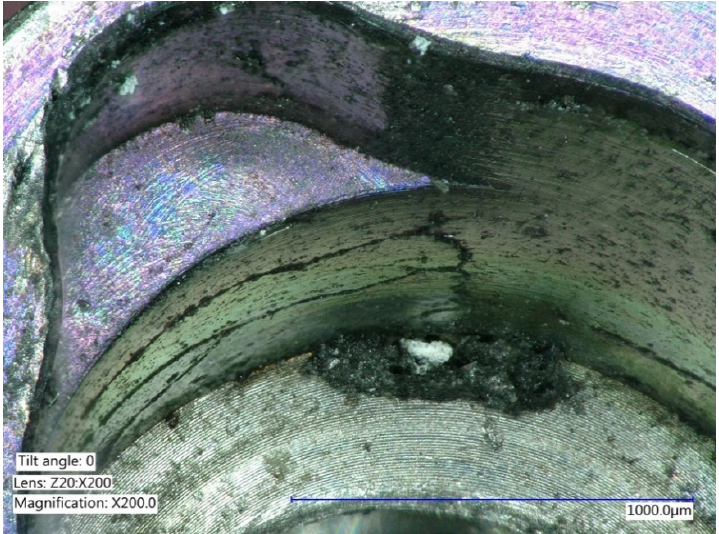
Figure 7. Explanted implant with a Trilobed connection. Increased magnification allows to observe fracture lines, corrosion, and accumulation of titanium particles potentially from implant-abutment connection wear.